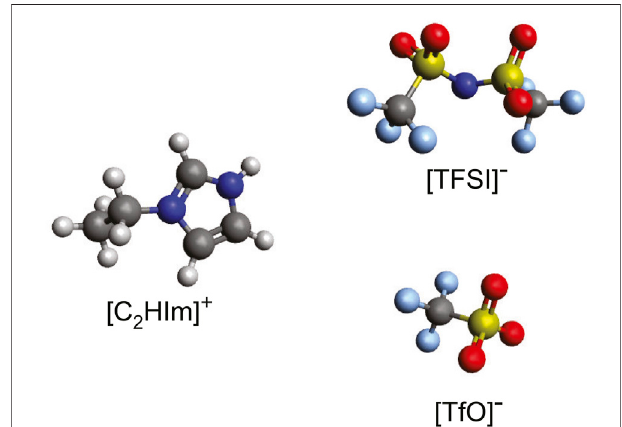
FIGURE 1 | Molecular structure of the 1-ethylimidazolium cation (C 2 HIm + ), and of the tri fl ate (TfO − ) and bis (tri fl uoromethylsulfonyl)imide (TFSI − ) anions, which are the constituting ions in the two protic ionic liquids investigated. The color code of the atoms is as follows: red, oxygen; gray, carbon; light blue, fl uorine; dark blue, nitrogen; and yellow, sulfur.